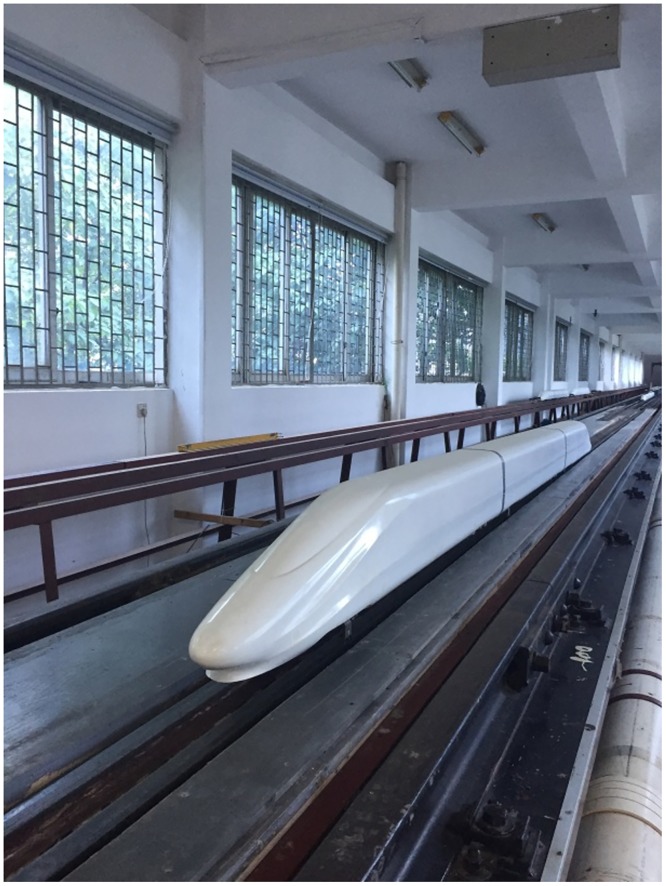
The train model.